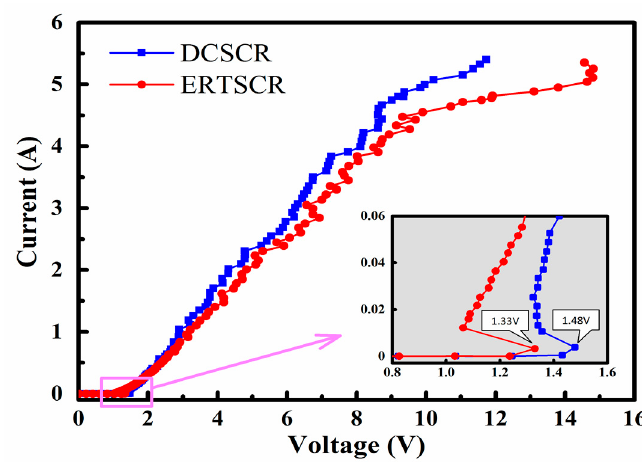
Figure 6. Measured TLP I-V curves of conventional DCSCR and proposed ERTSCR.